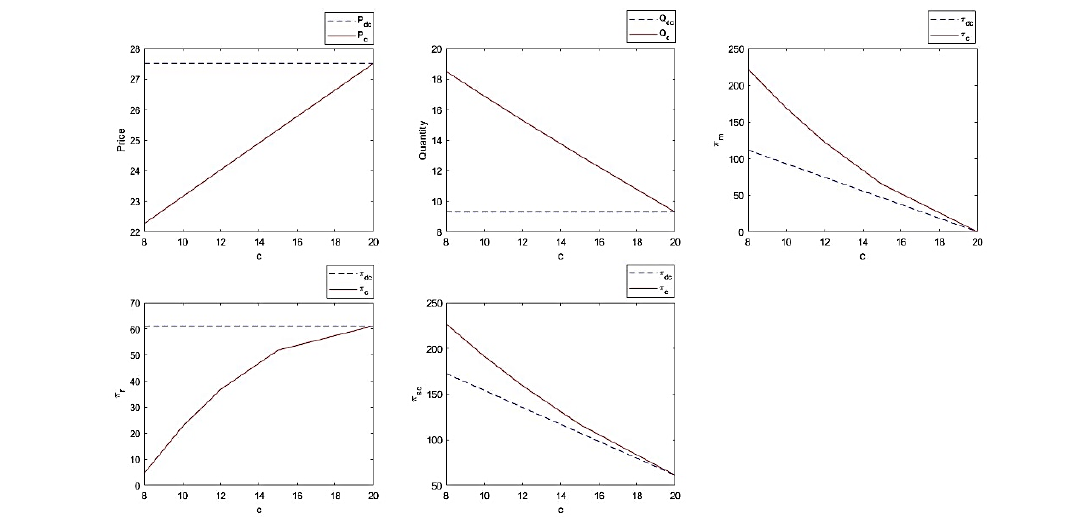
Fig. 2. The trend of variations in decision variables due to variations of production costs.